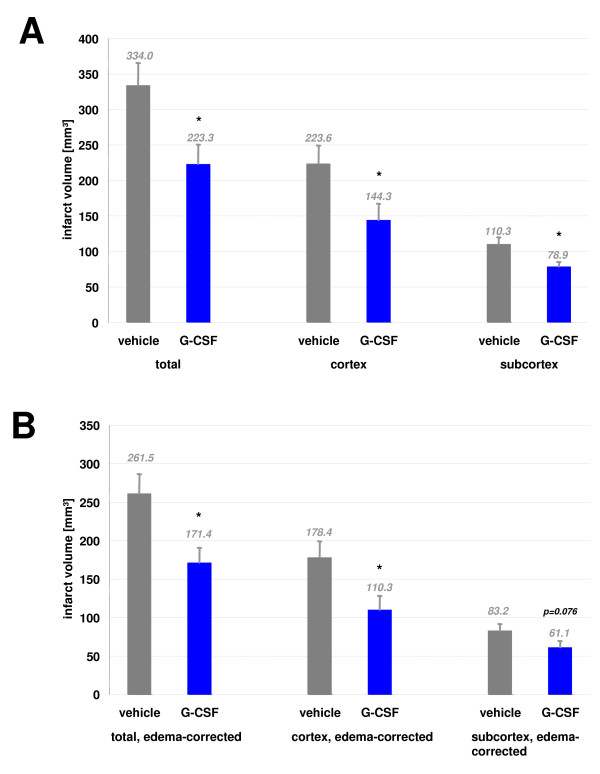
G-CSF reduces cortical and subcortical infarct volume in the rat MCAO model when applied 4 h after onset of ischemia. A. Shown are infarct volumes for the total infarct, cortical and subcortical areas. Infarct volumes were determined 24 h after onset of ischemia by TTC-staining and planimetry. B. Infarct volumes after edema correction. Edema-corrected infarct volumes were obtained by deducting the non-infarcted ipsilateral hemisphere volume from the contralateral hemisphere volume. Volumes are given in mm3 as means ± SEM.